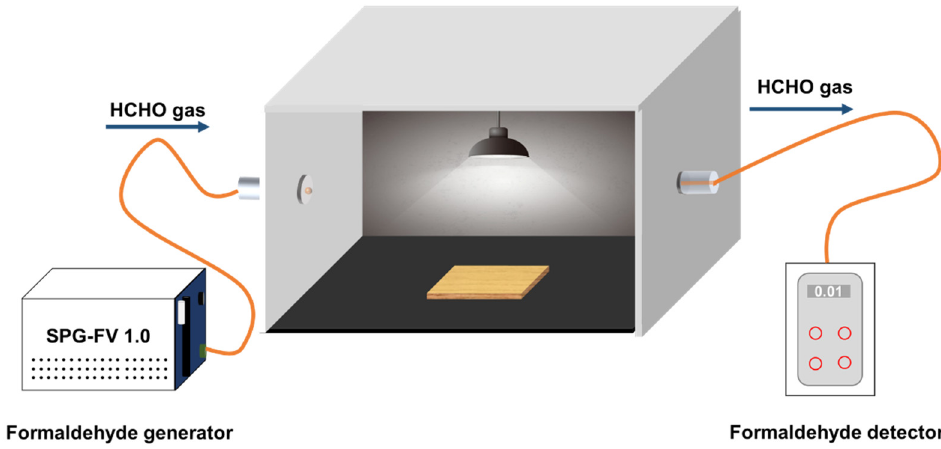
Figure 2. Reaction device for the photocatalytic degradation of